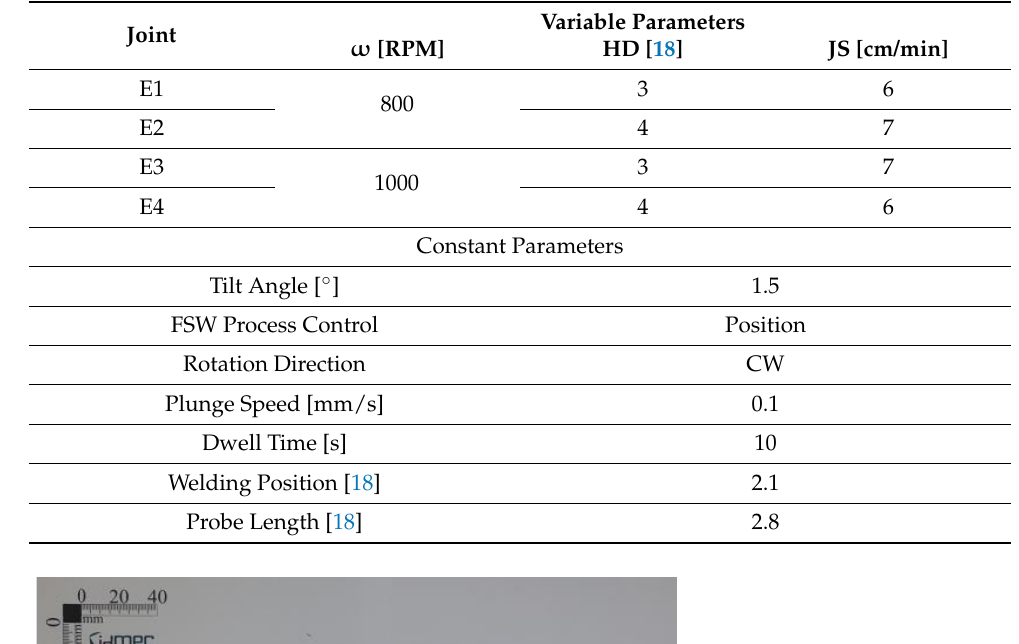
Table 2. The L4 orthogonal array for three parameters with three levels each, and the constant parameters in the AA-Ti joints and their levels.